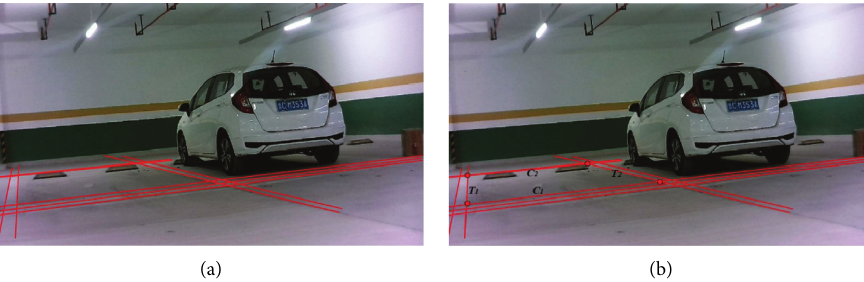
Figure 6: Parking space extraction based on Hough transform. (a) Parking line detection. (b) Parking space extraction.